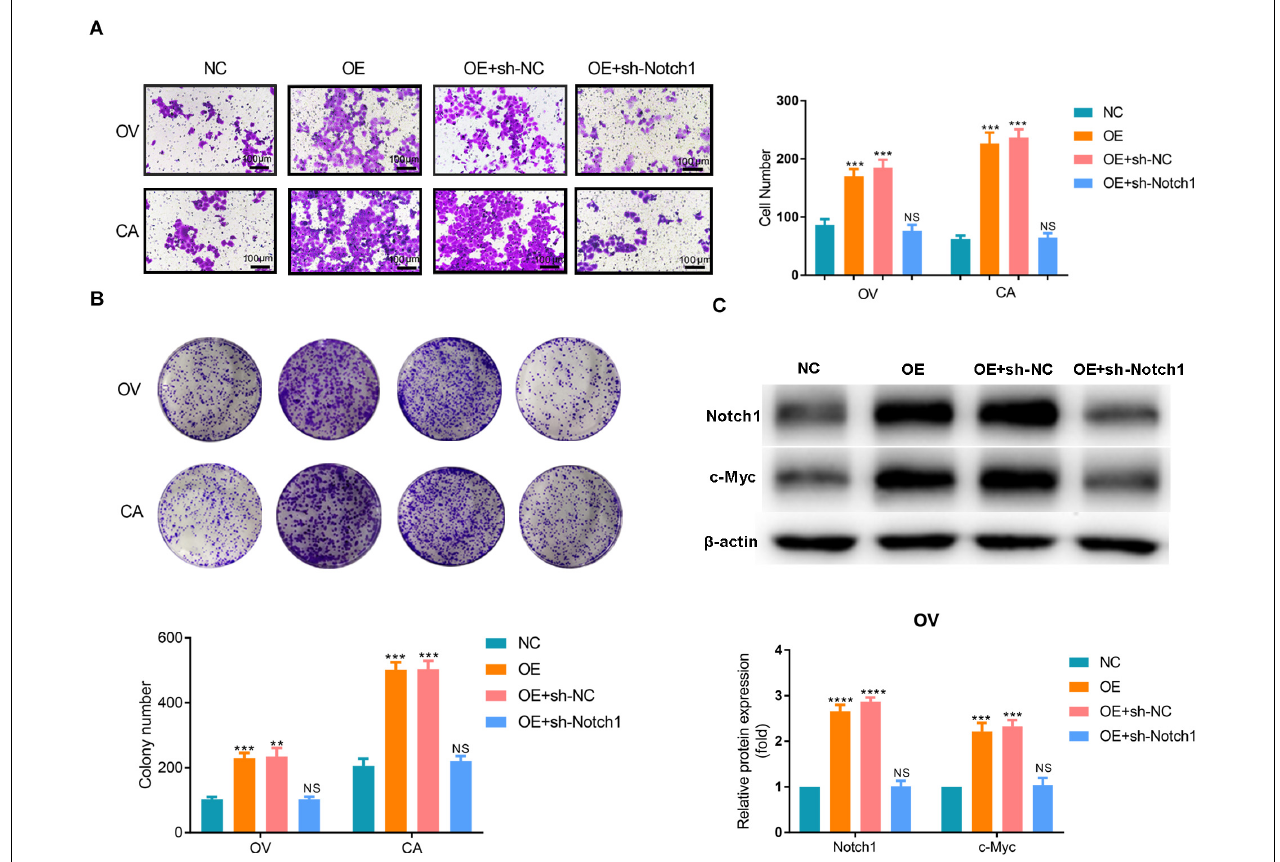
FIGURE 7 | SNORA72-NC, SNORA72-OE, SNORA72-OE+sh-NC, or SNORA72-OE+sh-Notch1 plasmids were, respectively, transfected in OVCAR-3 (OV) or CAOV-3 (CA) cells. (A) Migration abilities of OV and CA cells by the Transwell assay. (B) The self-renewal abilities of OV and CA cells were measured by colony formation assays. (C) Relative protein expressions of Notch1 and c-Myc to β -actin analyzed by Western blot in OV cells. ** P < 0.01, *** P < 0.001, and **** P < 0.0001.